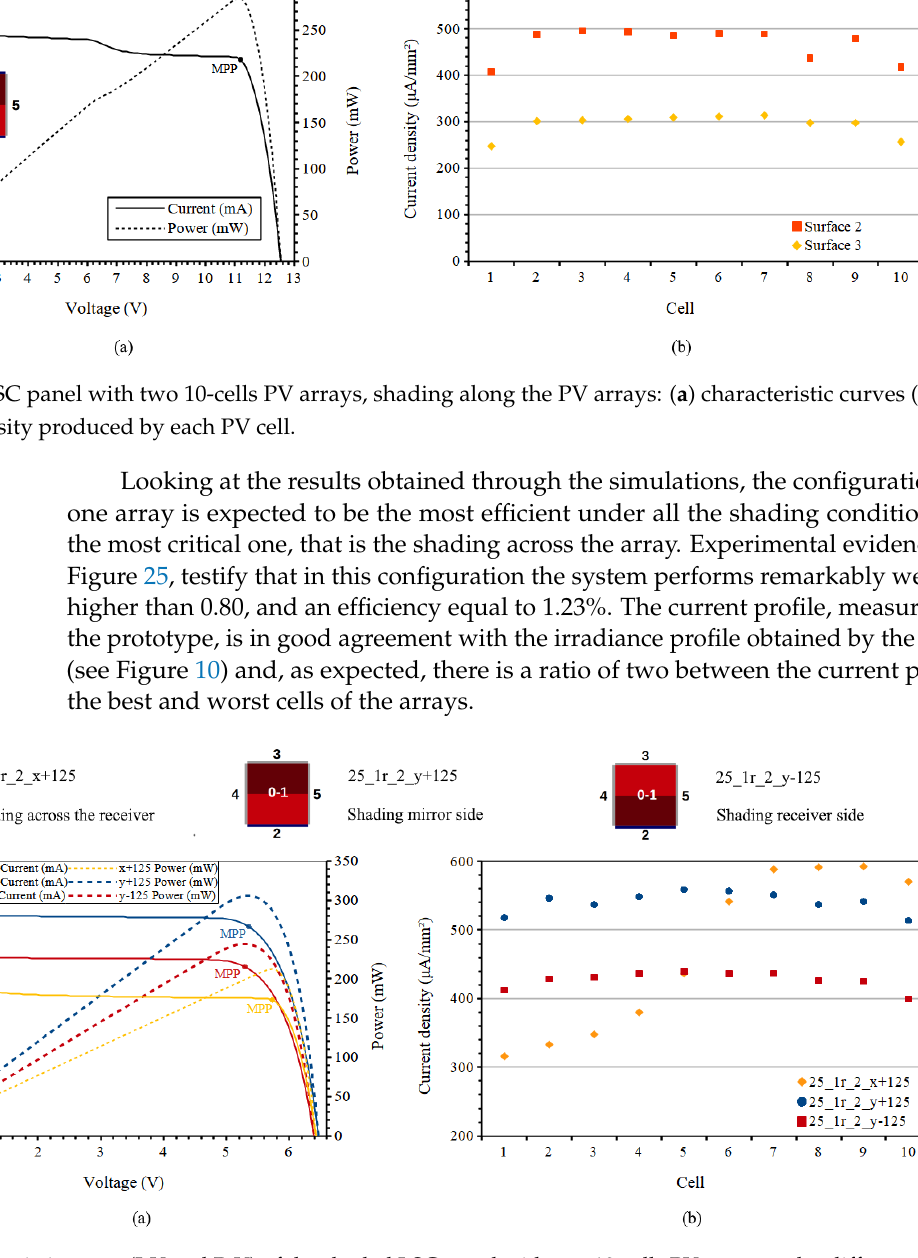
Figure 25. ( a ) Characteristic curve (I-V and P-V) of the shaded LSC panel with one 10-cells PV array, under different shading conditions: shading across the PV array (yellow), shading along the half surface opposed to the PV array (blue) and shading along the half surface near the PV array (red). ( b ) Current density produced by each configuration: shading along the receiver (yellow diamonds), shading along the half surface opposed to the PV array (blue circles) and shading along the half surface near the PV array (red squares).